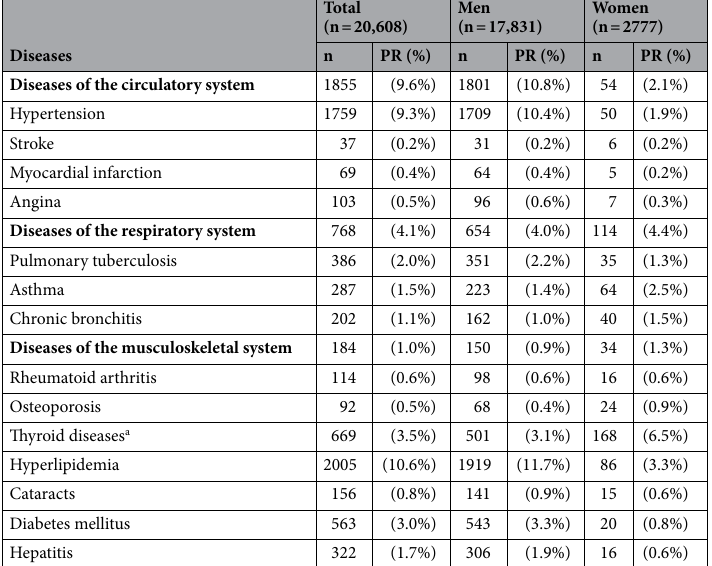
Table 1. Prevalence of non-cancer diseases in Korean radiation workers (n = 20,608). PR prevalence rate. a Including benign thyroid tumor, thyroid nodule, thyroid goiter, thyroiditis, hyperthyroidism, and hypothyroidism.